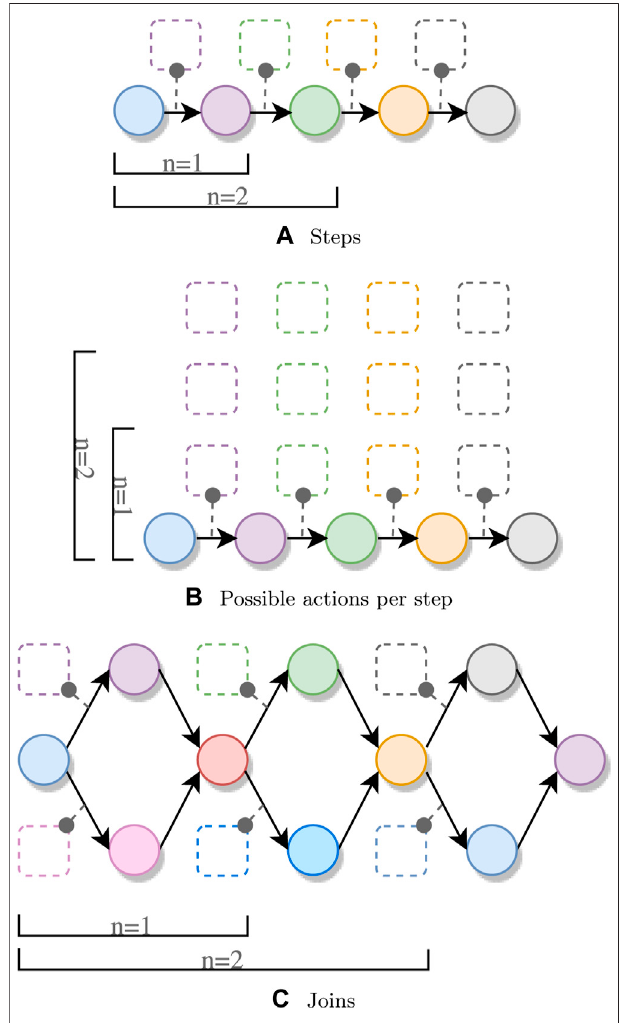
FIGURE 5 | Plan generation for a varying number of (A) steps, (B) possible actions per step, and (C) joins. Circles and rectangles represent steps and actions,